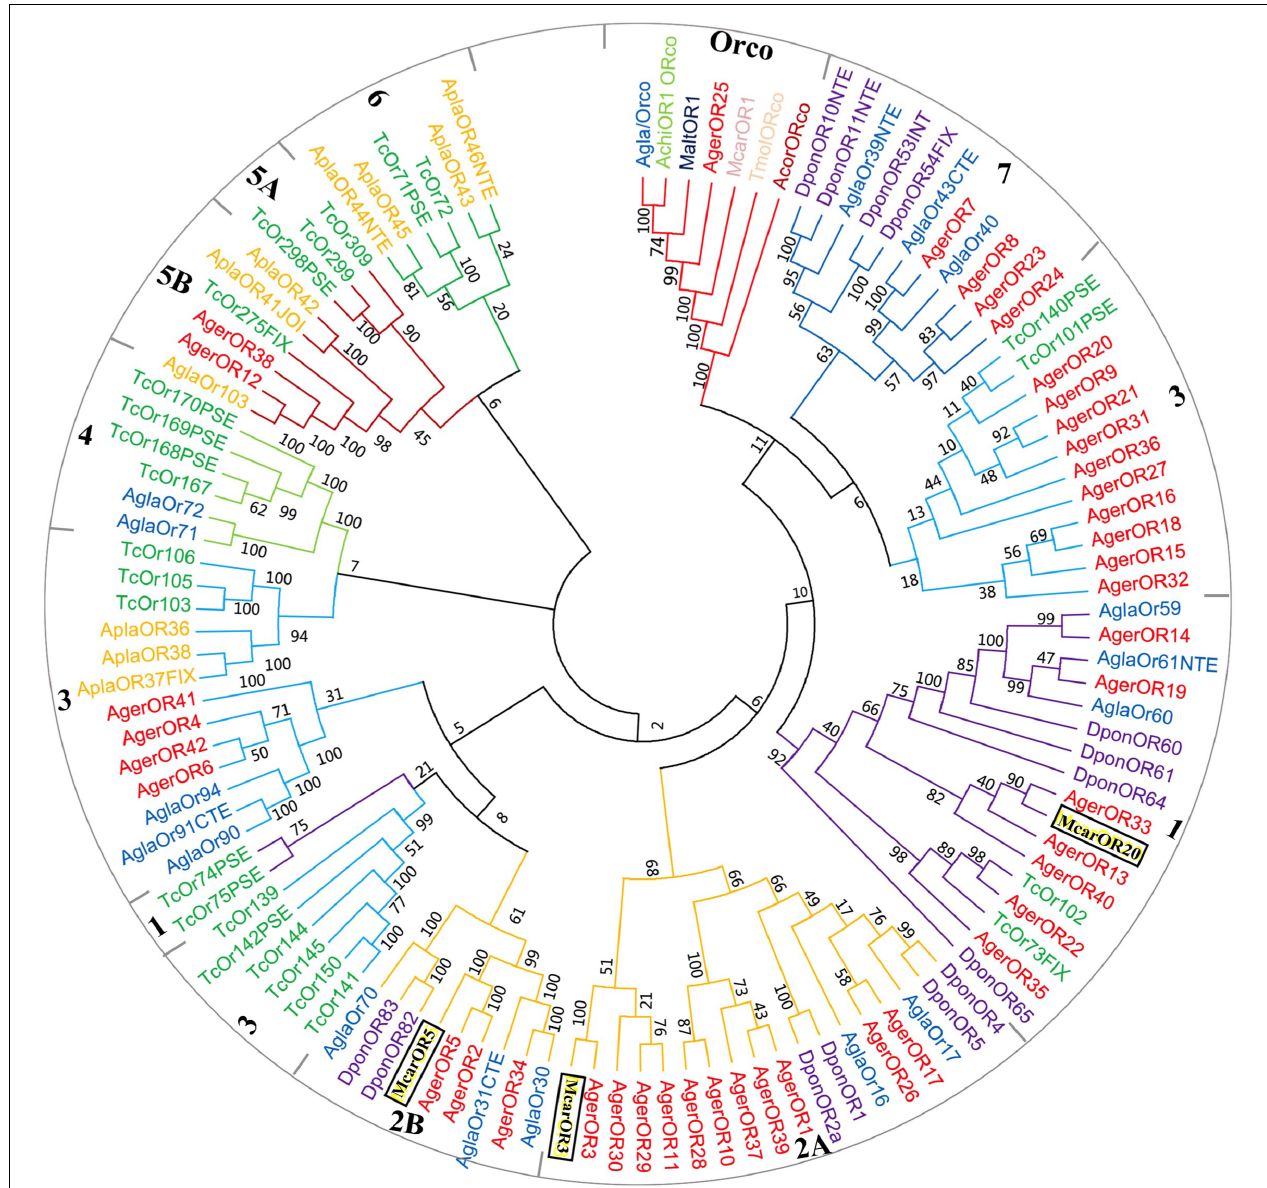
FIGURE 4 | Molecular phylogeny comparing AgerORs with odorant receptors (ORs) from 10 insect species. A total of 42 ORs (AgerOR1–42) from Apriona germari (Ager) and ORs from Anoplophora chinensis (Achi), Anoplophora glabripennis (Agla), Agrilus planipennis (Apla), Dendroctonus ponderosae (Dpon), Tribolium castaneum (Tcas), Anomala corpulenta (Acor), Monochamus alternates (Malt), Megacyllene caryae (Mcar), and Tenebrio molitor (Tmol) were used to construct the phylogenetic tree (see section “Materials and Methods” for details of the phylogenetic